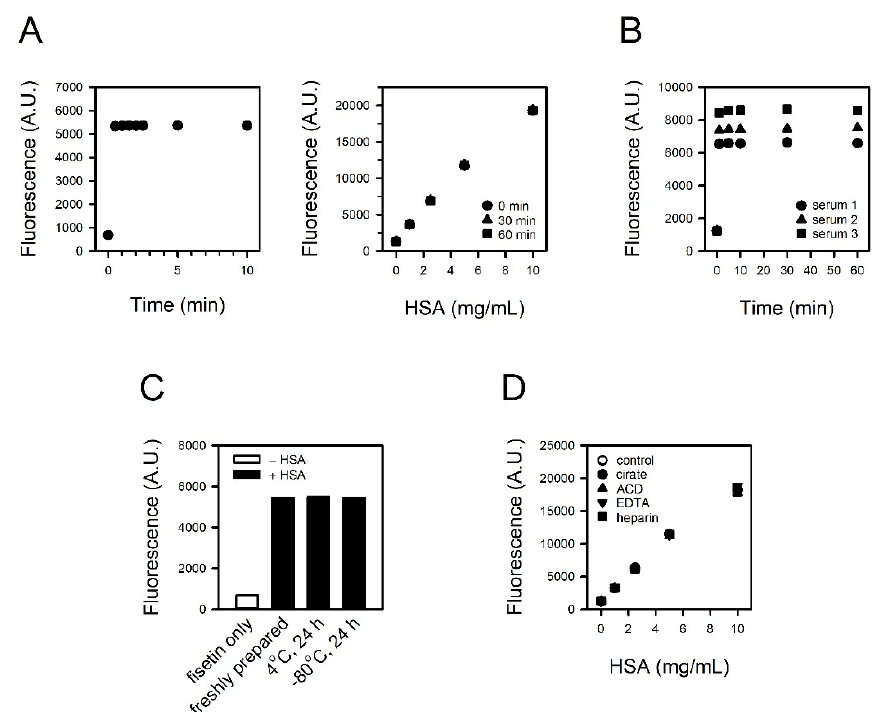
Figure 2. Reaction rate, signal stability, and the impact of sample storage condition and anticoagulants on assay. ( A ) The fluorescence was measured from 0.5 to 10 min after inducing the reaction of 30 µ M fisetin and 5 mg / mL HSA (left panel). The stability of the fluorescence signal was tested up to 60 min (right panel). ( B ) The fluorescence from 30 µ M fisetin and 10% serum was measured from 1 to 60 min. ( C , D ) The HSA solutions were prepared ( C ) freshly or kept at 4 ◦ C or − 80 ◦ C for 24 h, and ( D ) to contain citrate, ACD, EDTA or heparin. They were reacted with fisetin, and the fluorescence intensities were